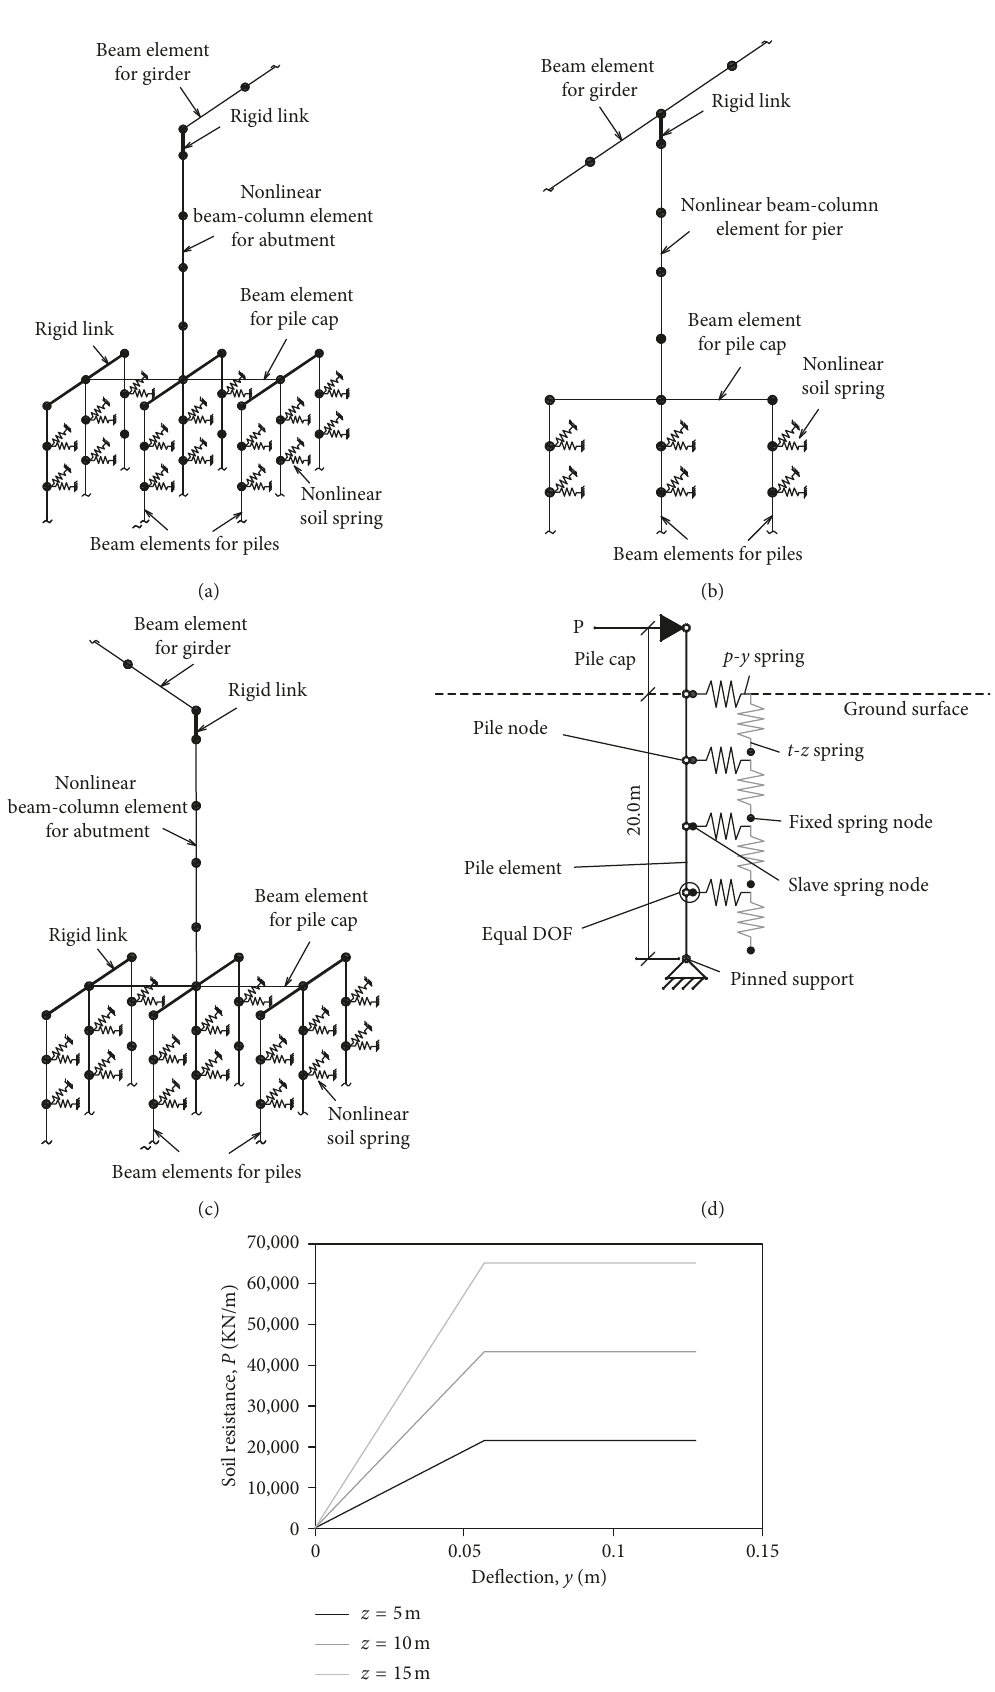
Figure 7: Element discretization of the (a) left abutment, (b) pier, and (c) right abutment pile foundation. (d) Soil-pile interaction. (e) p-y